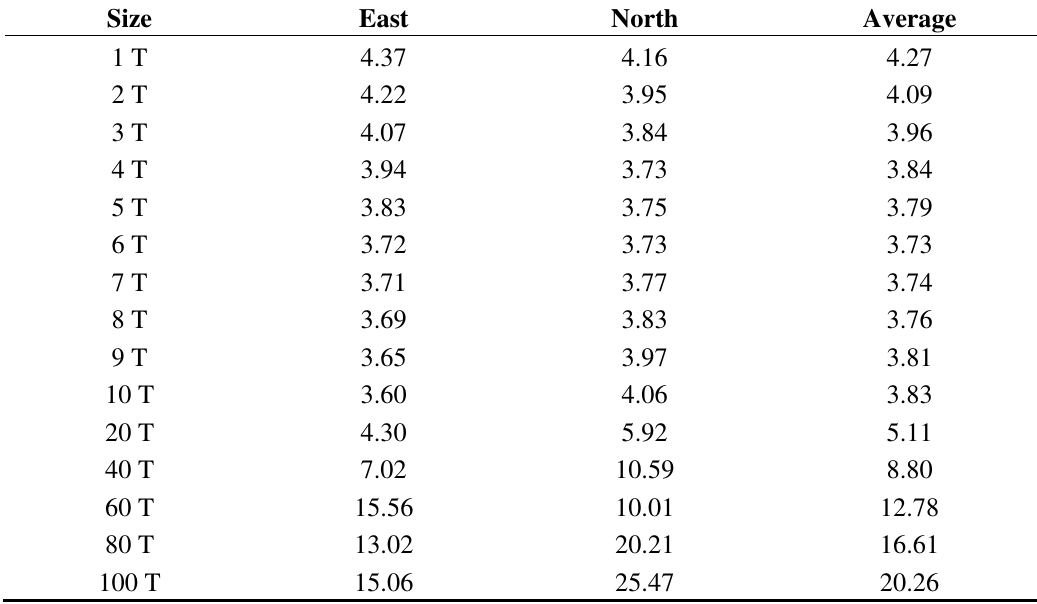
Table 5. Relationship between smoothing window size and position RMSE (cm).